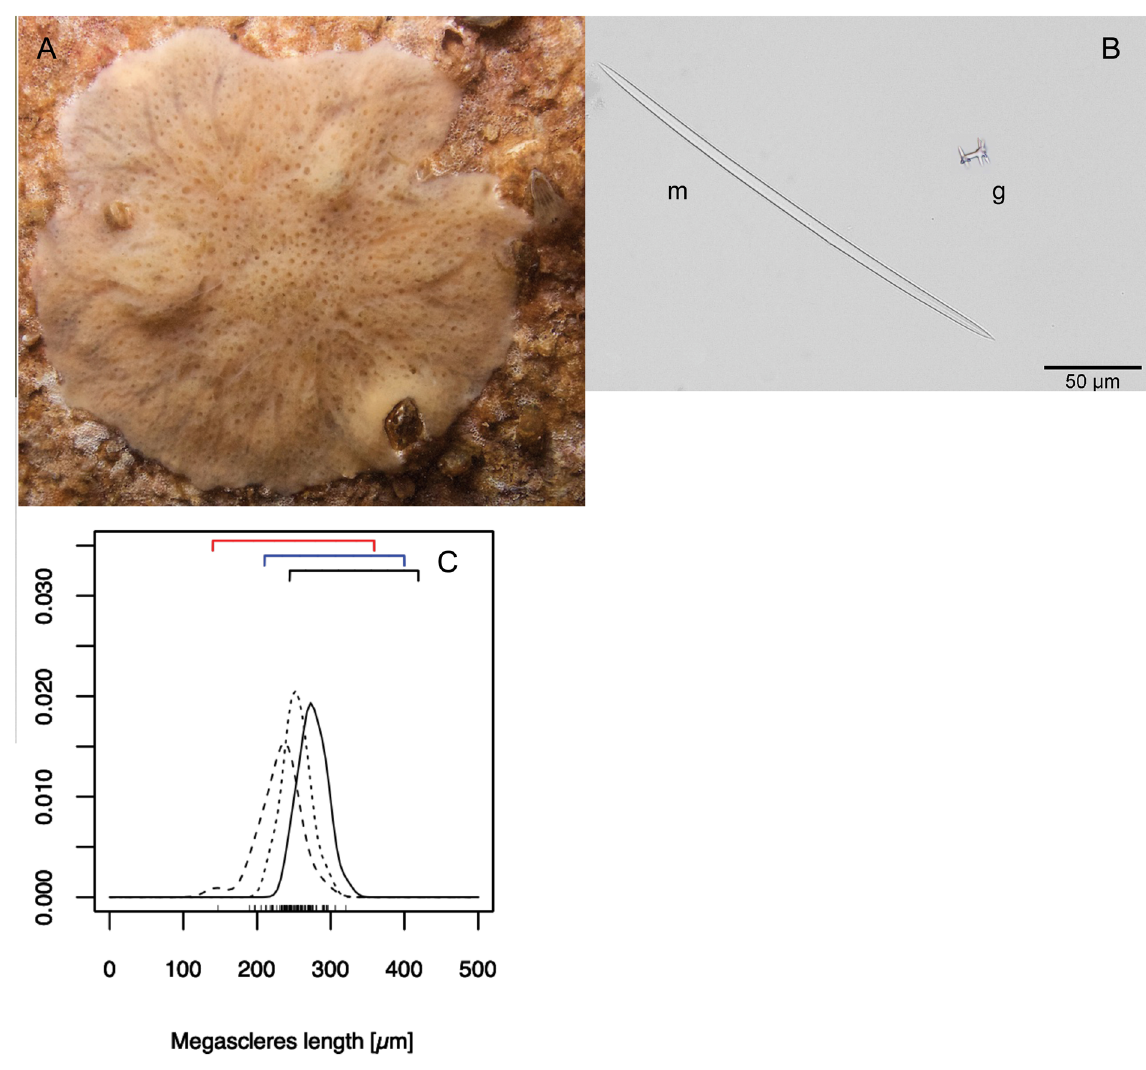
Fig. 3. Ephydatia fluviatilis (Linnaeus, 1759) . A . Habitus (P059-211231-1). B . Spiculae, m = megasclere (P059-170902-2), g = gemmulosclere (P059-170902-1). C . Estimated megasclere size distribution within and between specimens, P059-170902-1 (solid line), P059-170902-2 (dashed), P059-170902-3 (dotted). Marks on the x-axis represent spiculae measured. Brackets correspond to ranges in literature (red = Tendal 1967b; blue = Penney & Racek 1968; black = Evans & Montagnes